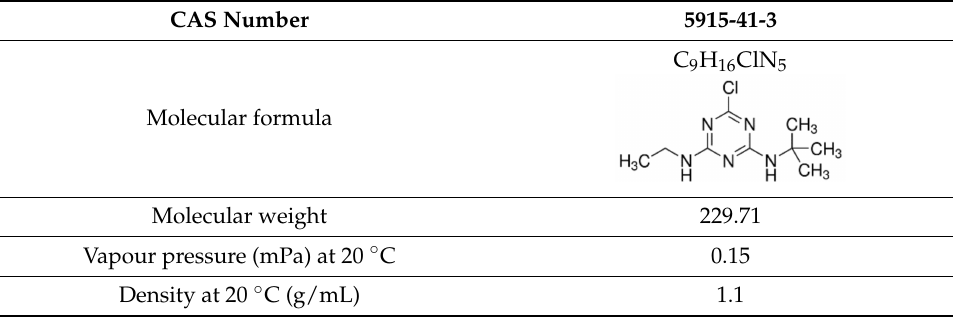
Table 3. Physico-chemical characteristics of